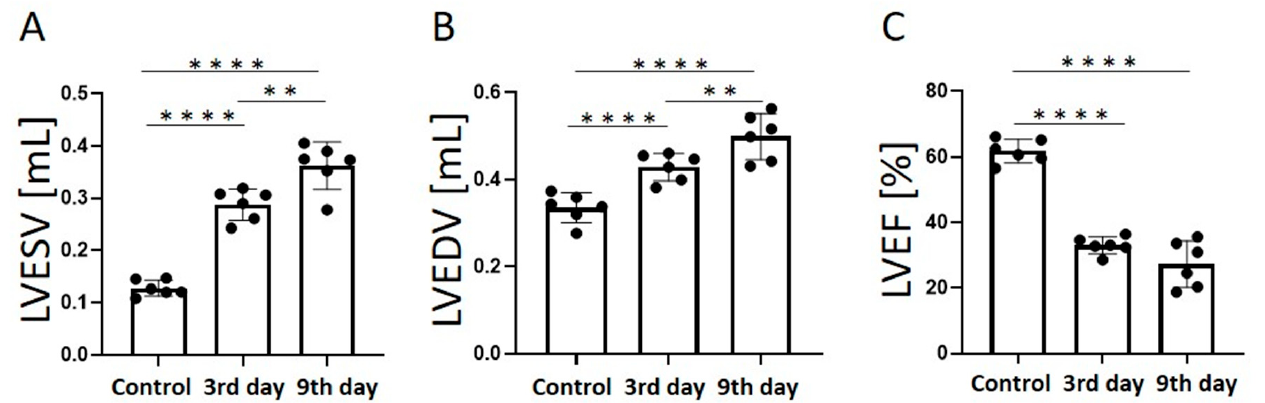
Figure 4. Graphs quantifying LVESV ( A ), LVEDV ( B ), and LVEF ( C ) in the control group, 3 days after the onset of myocardial infarction, and 9 days after the onset of myocardial infarction. LVESV, left ventricular end-systolic volume; LVEDV, left ventricular end-diastolic volume; LVEF, left ventricular ejection fraction. ** p < 0.01, **** p < 0.0001. The RVESV (Figure 5A) did not change significantly after the onset of MI, but it increased slightly on day 9 (control, 0.08 ± 0.01 mL; day 3, 0.08 ± 0.02 mL; day 9, 0.09 ± 0.02 mL). The RVEDV (Figure 5B) decreased significantly 3 days after the onset of MI compared to the control group (control, 0.2 ± 0.03 mL; day 3, 0.2 ± 0.04 mL, p < 0.05). There was no significant difference between days 3 and 9. The RVEF decreased significantly 9 days after MI compared to the control group (control, 66.9 ± 3.8%; day 3, 58.8 ± 4.9%; day 9, 51.5 ± 9.0%, p < 0.01).